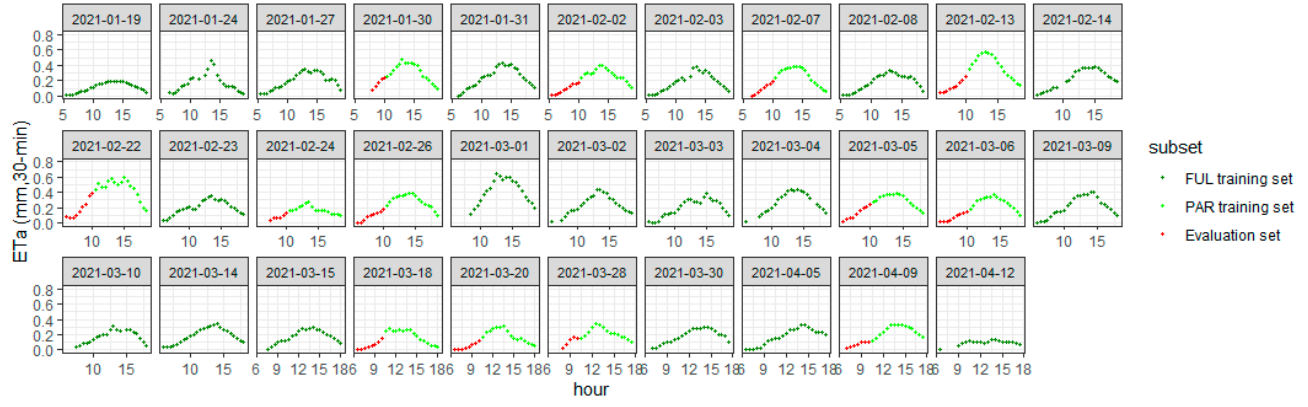
Figure 5. Split of the training and evaluation subsets to represent missing data Type A, i.e., missing morning. ing